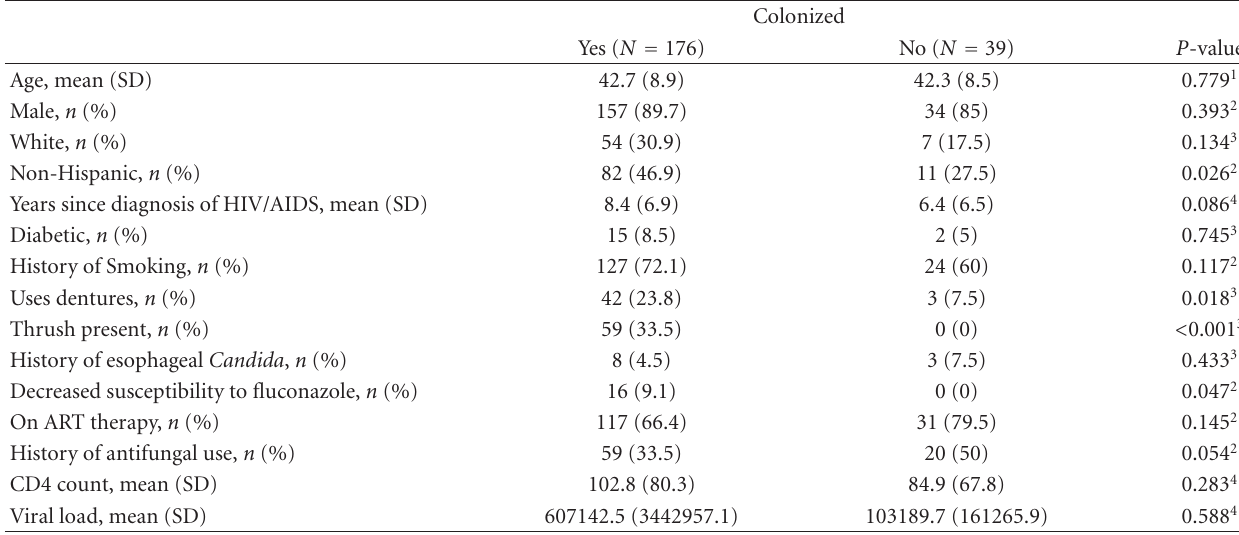
Table 1: Patient demographics of 215 subjects by colonization